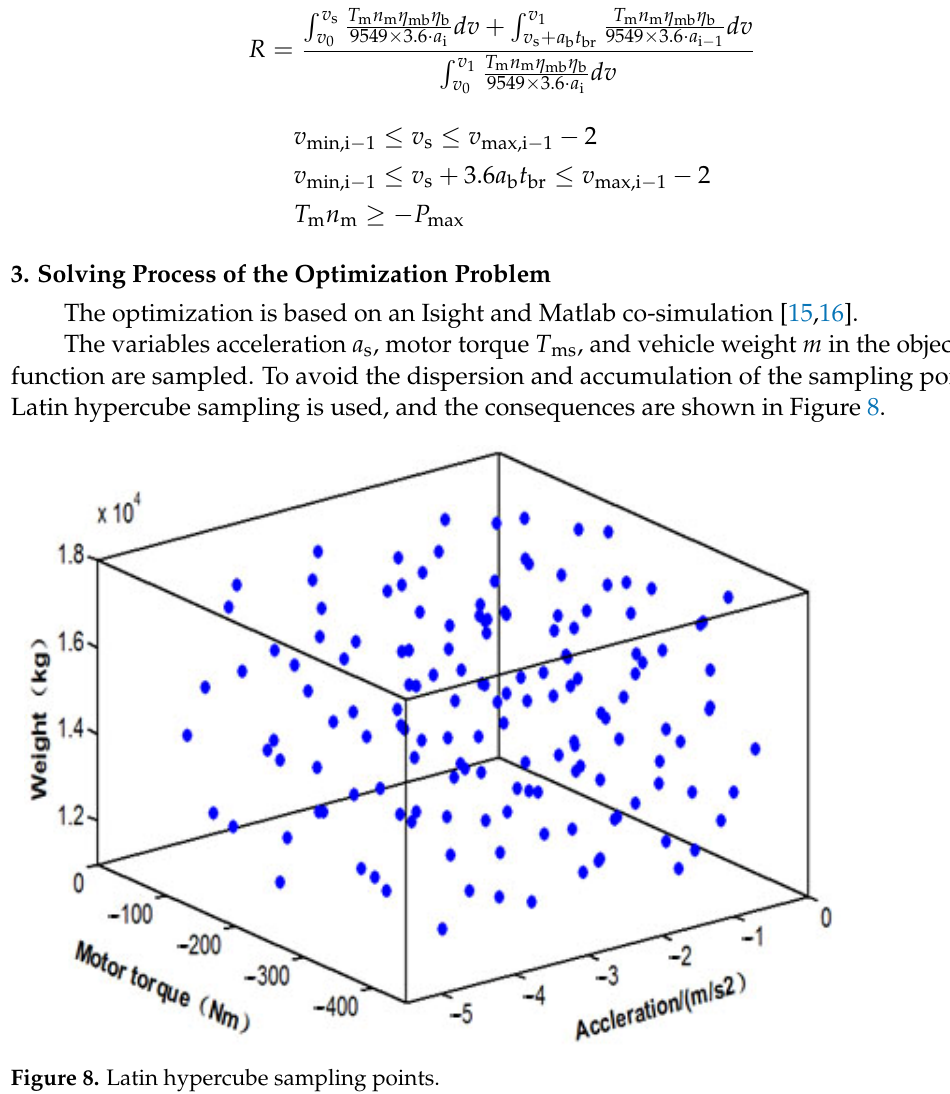
Figure 9. Correlation between shift condition factor and optimum downshifting speed. As can be seen from Figure 9, the gear shifting condition factor r has the greatest correlation with speed reduction, and the correlation coefficient is very close to 1, followed by the motor torque during gear shifting, which has basically no correlation with vehicle weight. The optimal downshift speed vs has a greater correlation with the speed reduction and motor torque but less correlation with vehicle weight. Fuzzy control is used in the gear shifting schedule to avoid shifting frequently during the braking process. The objective function R is fuzzed, as shown in Figure 10.